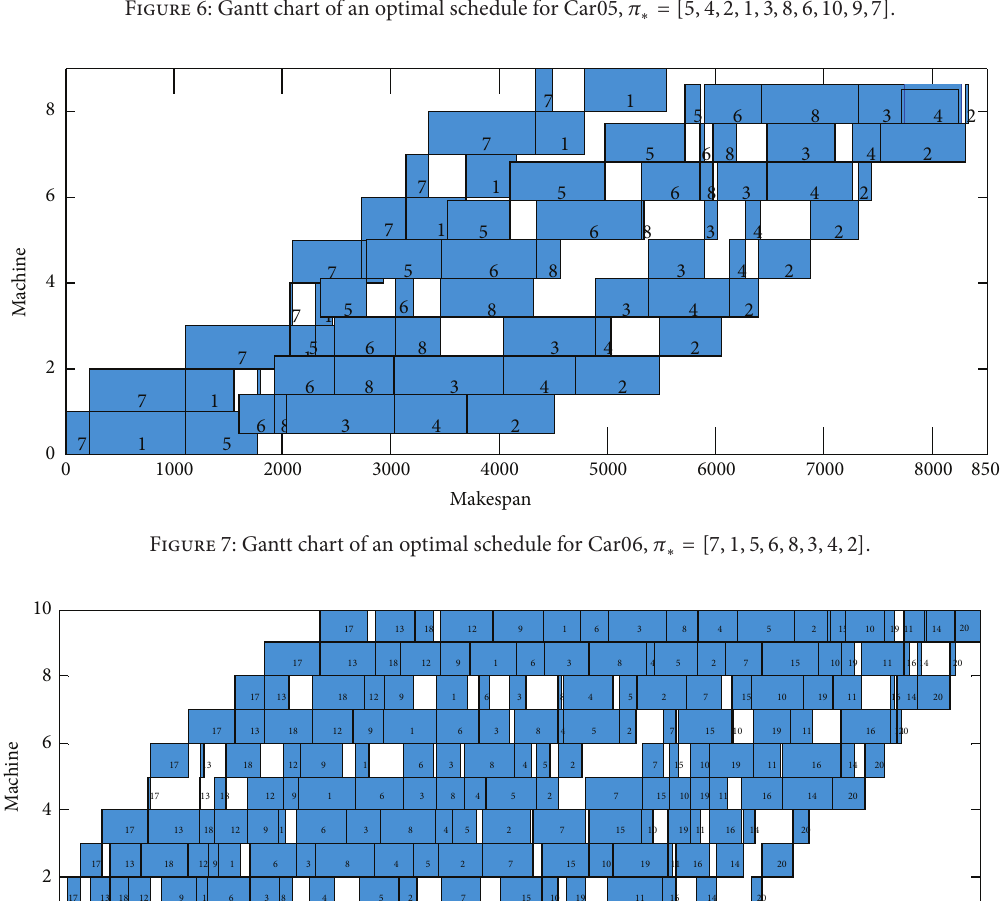
Figure 6: Gantt chart of an optimal schedule for Car05, 𝜋 ∗ = [5,4, 2,1, 3, 8, 6,10, 9, 7] .